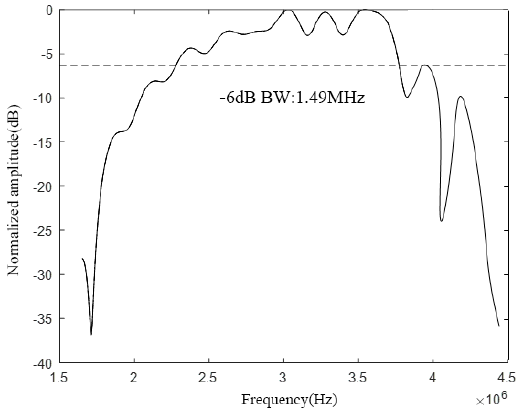
Figure 19. CMUT bandwidth ( w = 80%).